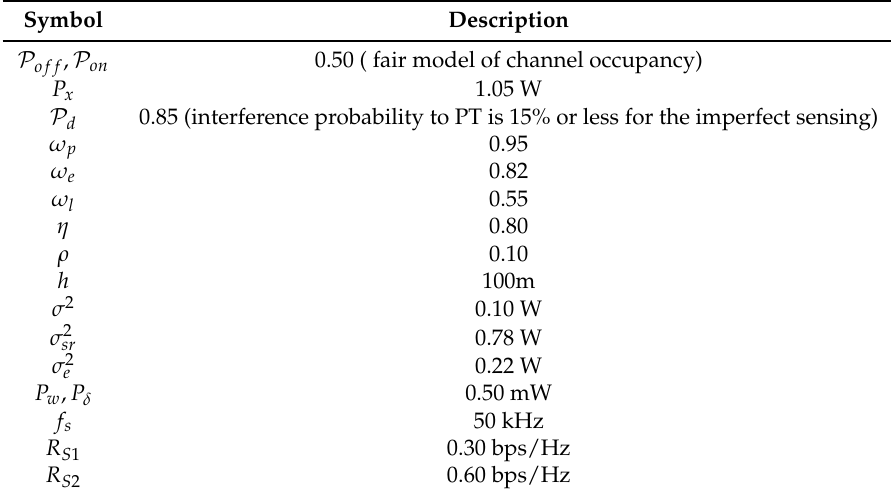
Table 1. System configuration for numerical simulations.